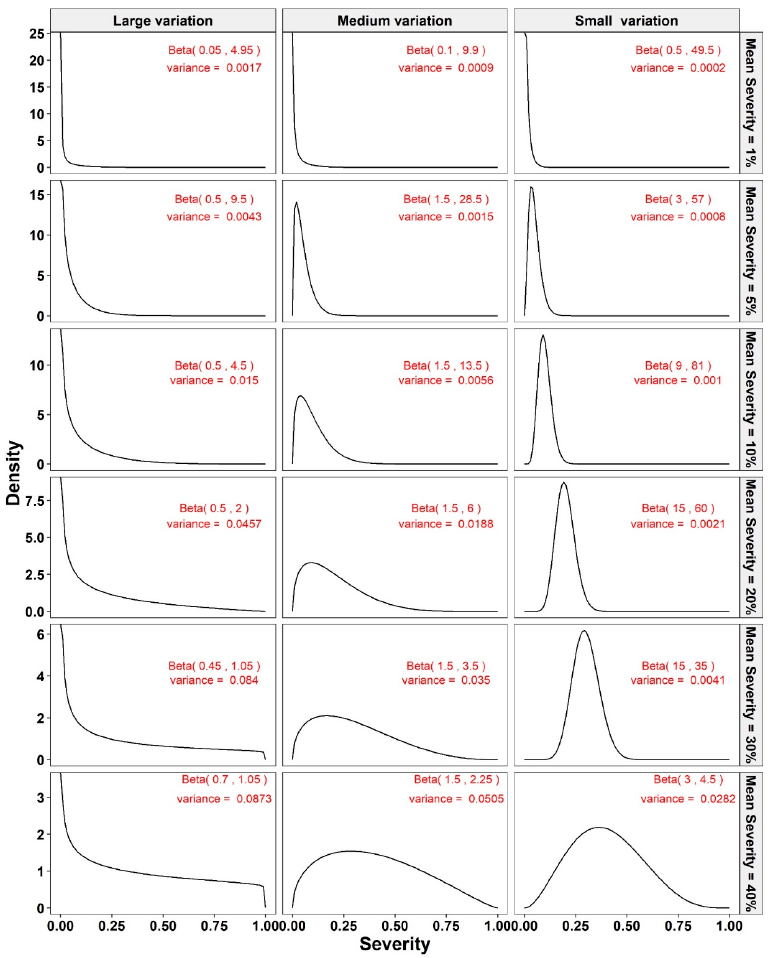
Figure 1. A beta-distribution was used to simulate the random variables representing disease severity. The means of the random variables of the beta-distributions were set at 1, 5, 10, 20, 30, and 40% severities to demonstrate a range of possible “actual” mean disease severities (%). Furthermore, we selected three different variance parameter settings (representing large, medium, and small variation) for the fixed means to illustrate the effect of the variance of estimates with the different assessment methods.